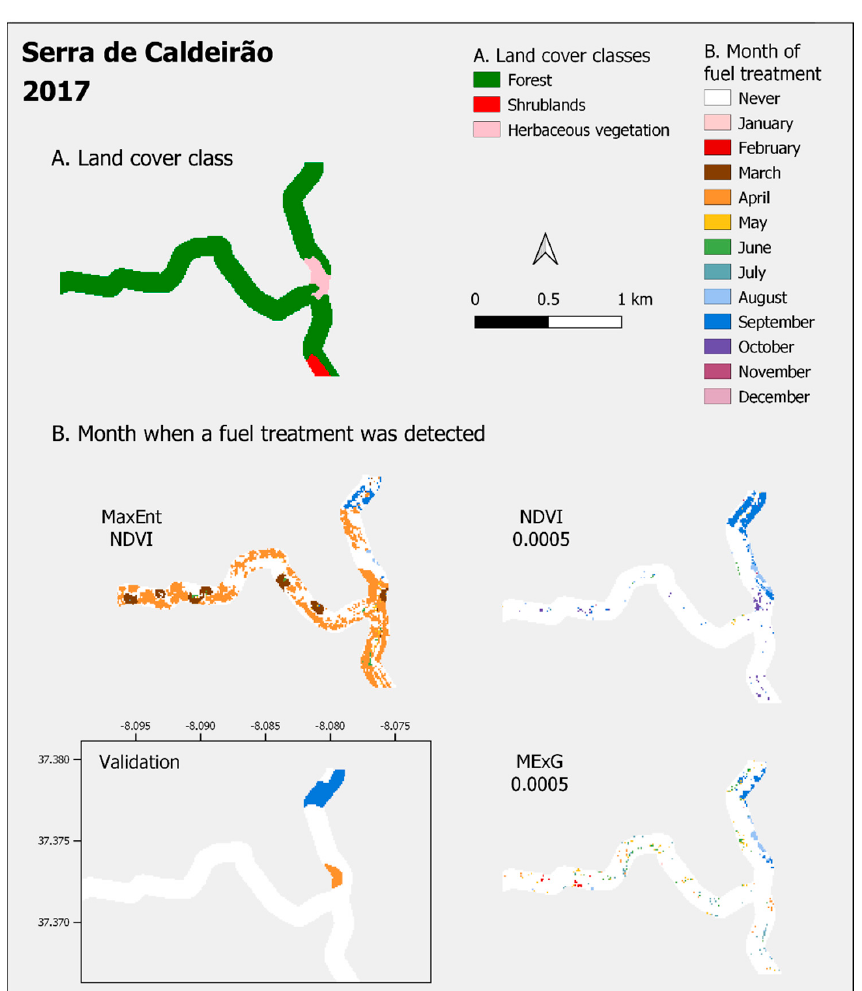
Figure 10. Results in a cork oak woodland area of Serra de Caldeirão in 2017: A. land cover; B. results of Method 1, MaxEnt NDVI classification, and Method 2, NDVI and MExG statistical detection with α = 0.0005.